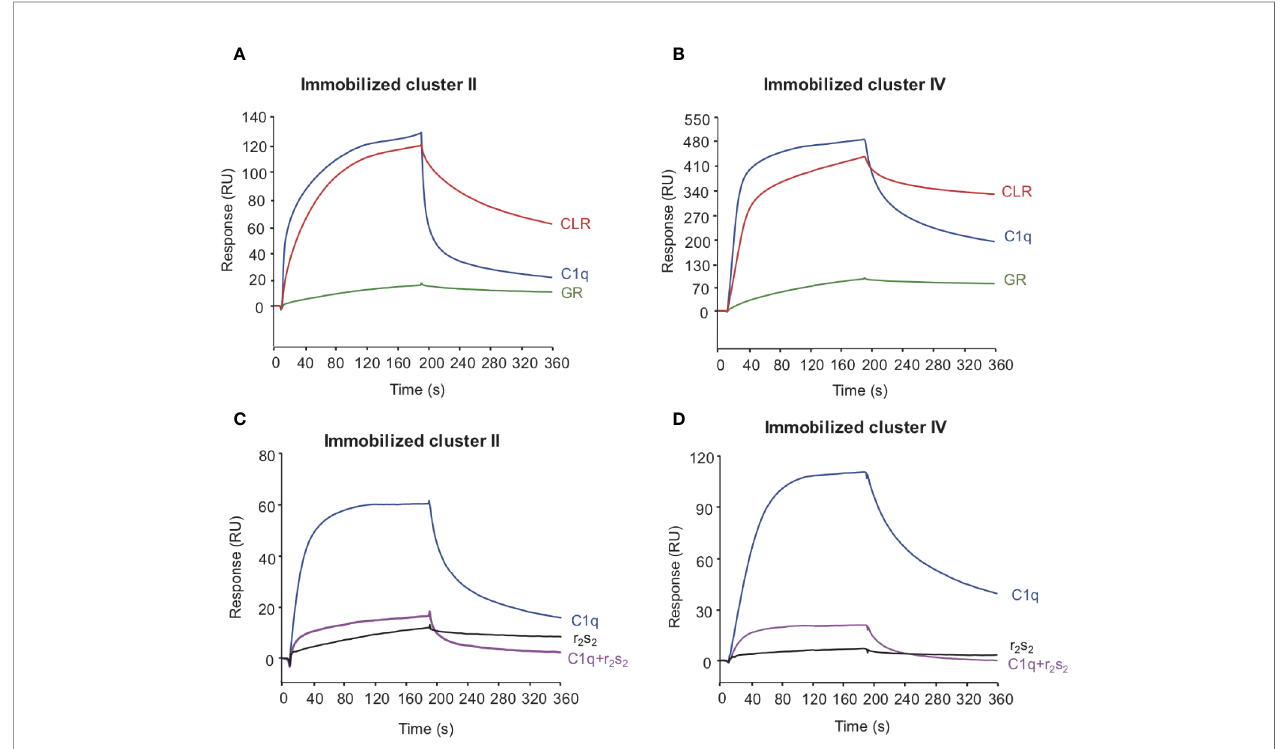
FIGURE 6 | The interaction site of LRP1 clusters II and IV on C1q is located on the collagen stalks at or close to the site interacting with C1r2s2 tetramer. C1q (10 nM, blue curves), CLR (10 nM, red curves) and GR (60 nM, green curves) were injected over immobilized LRP1 cluster II (1,230 RU, A panel) or LRP1 cluster IV (1,270 RU, B panel), in 50 mM Tris, 150 mM NaCl, 2 mM CaCl 2 , 0.05% P20, pH 7.4. C1q (1 nM) was injected on the same amount of clusters II and IV (bottom C, D ) with (pink curves) or without (blue curves) C1r2s2 (1 nM). r2s2 was also injected alone (1 nM) as a reference (black